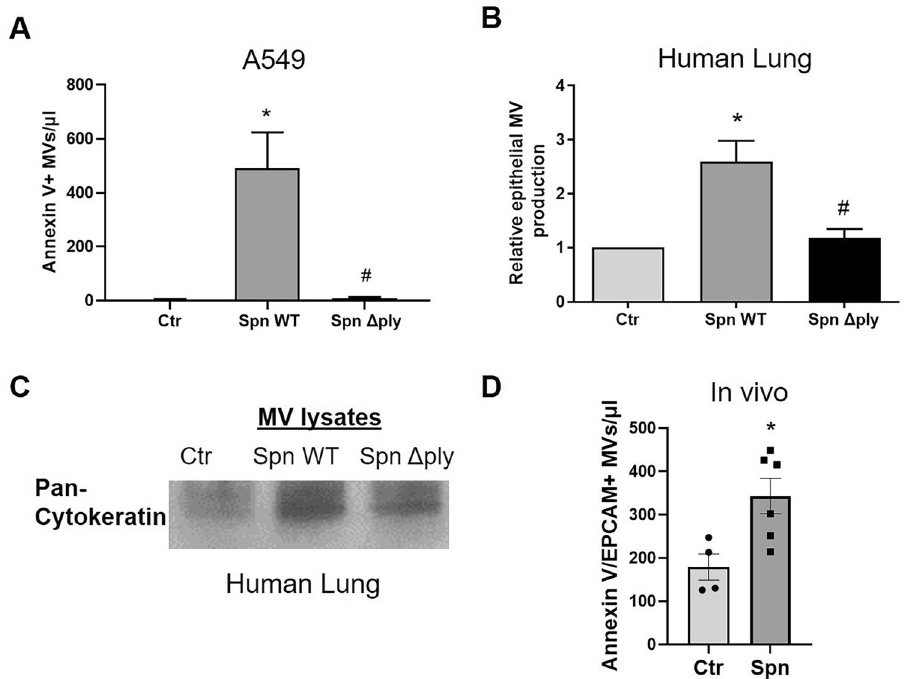
Figure 4. Streptococcus pneumoniae (Spn) induces epithelial microvesicle (MV) production via pneumolysin. ( A ) A549 cells were treated with Spn WT, Spn Δply (MOI 50), or PBS (Ctr) for 4 h and MVs were isolated from conditioned media. Annexin V + MVs were quantified by FACS. N = 4 *p < 0.01 vs Ctr, #p < 0.01 vs Spn Δ ply (One-way Anova). ( B,C ) Human lung specimens (pieces from the same lung) were treated with Spn WT, Spn Δply (1 × 10 6 CFU/ml), or PBS. ( B ) Graph depicts the relative amount of annexin V/EPCAM double positive MVs (normalized to Ctr). N = 6, *p < 0.05 vs Ctr, #p < 0.05 vs Spn ΔPly (One-way Anova). ( C ) MV lysates from human lung tissue supernatants probed for pan-cytokeratin (epithelial marker). Depicted is a representative blot (cropped image). ( D ) MVs of epithelial origin (annexin V/EPCAM double positive) were quantified in BAL of mice treated intranasally with Spn or PBS (Ctr). Each mouse is represented by a dot. N = 4–6, *p < 0.05 (unpaired